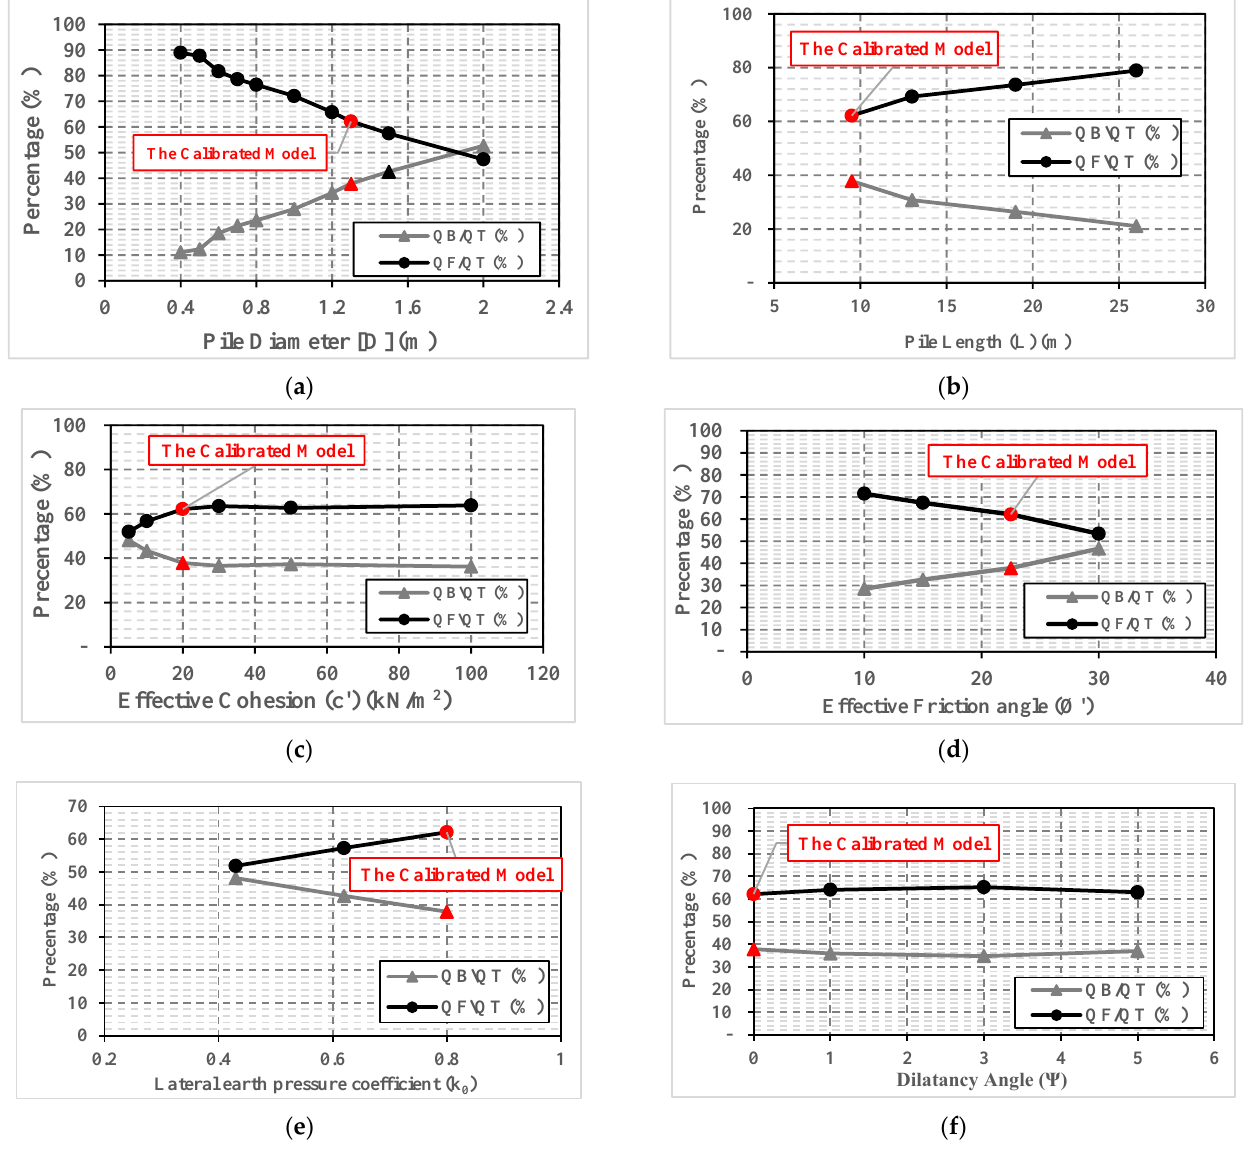
Figure 6. Variation of (Q B /Q T ) and (Q F /Q T ) with different parameters. ( a ) Pile diameter (D). ( b ) Pile length (L). ( c ) Effective cohesion (c’). ( d ) Effective friction angle (Ø’). ( e ) Lateral earth pressure coefficient (k 0 ) ( f ) Dilatancy angle ( Ψ ).